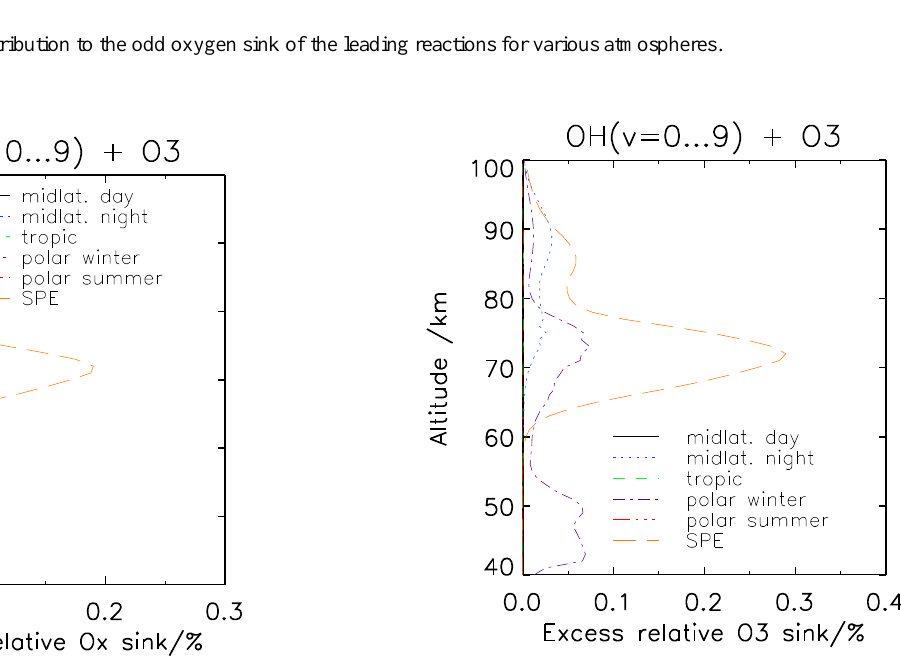
Fig. 6. Excess relative ozone sink by consideration of vibrationally excited OH in the OH+O 3 reaction as a function of altitude for var- ious atmospheres.